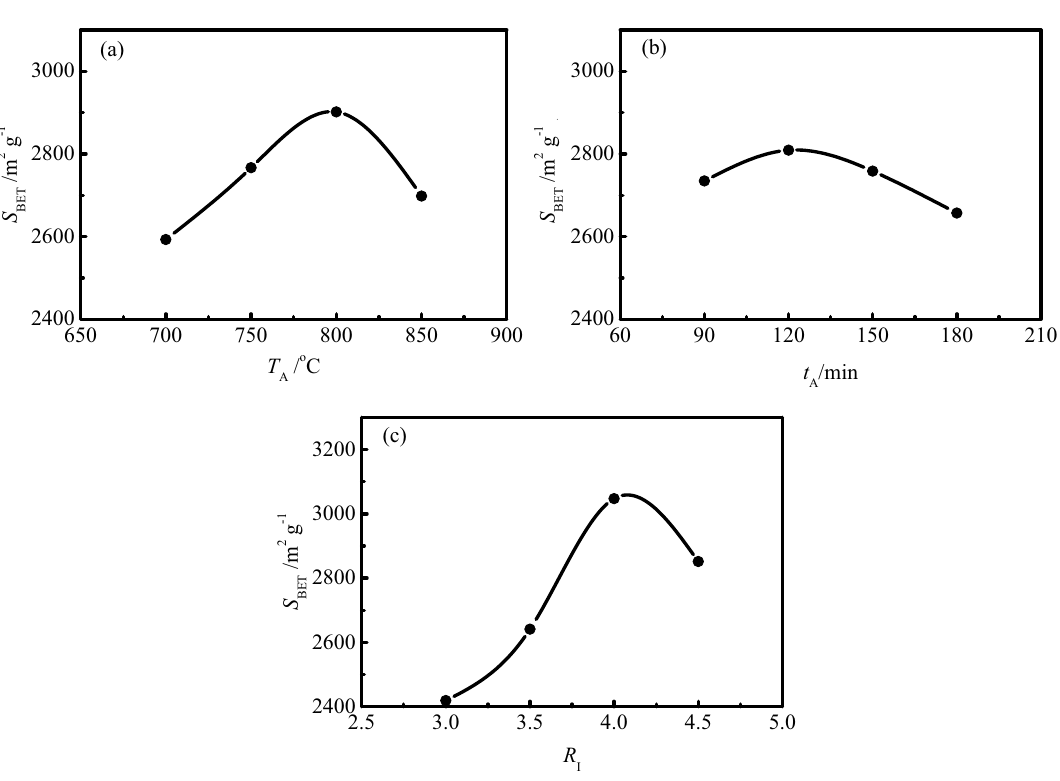
Figure 1. Effects of experimental factors on the specific surface area of